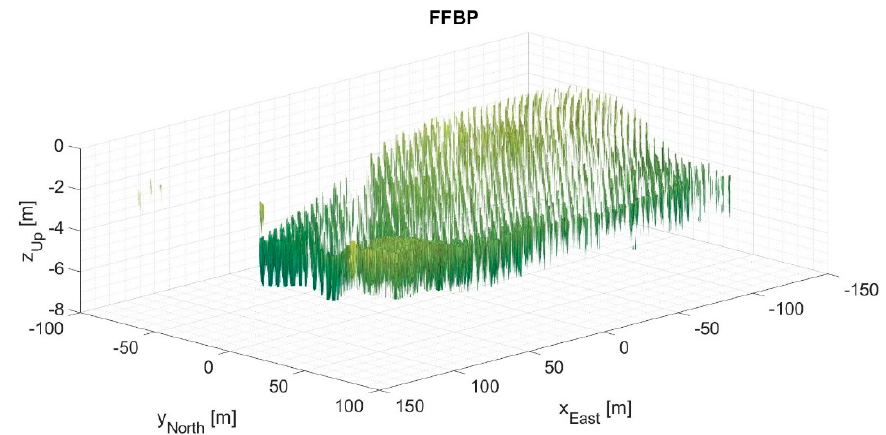
Figure 10. 3D output image processed by the FFBP algorithm with L = 5 and an (8 × 4 × 1) initial partition. Perspective view of isosurfaces at − 15 dB normalized magnitude.